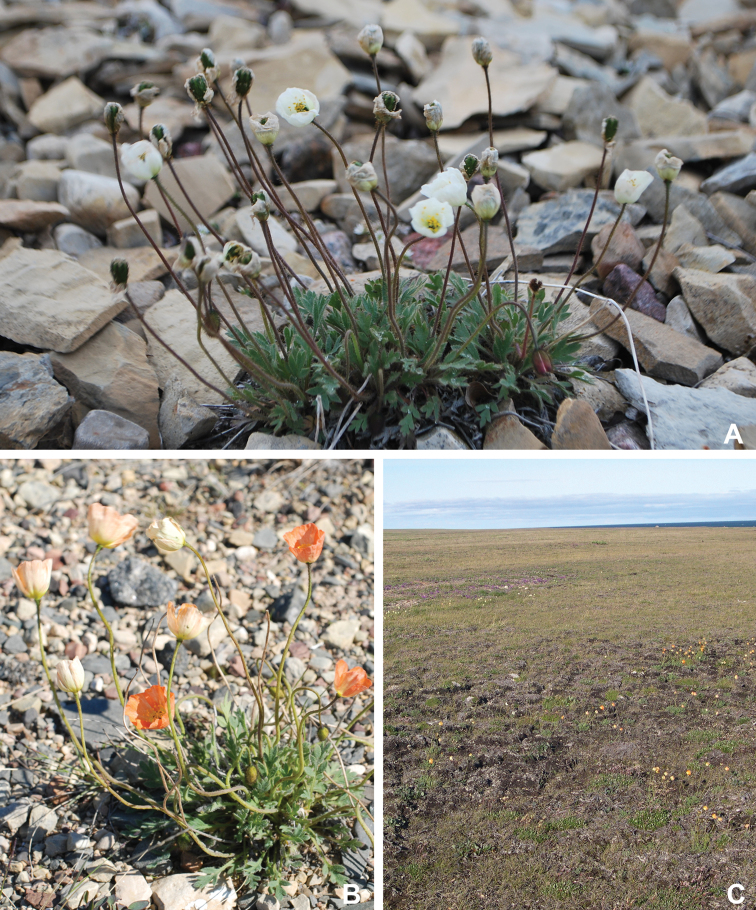
APapaver
dahlianum habit BPapaver
hultenii habit, Gillespie et al. 8239CPapaver
hultenii habitat, Gillespie et al. 8239. Photos A by B.A. Bennett and B, C by L.J. Gillespie.